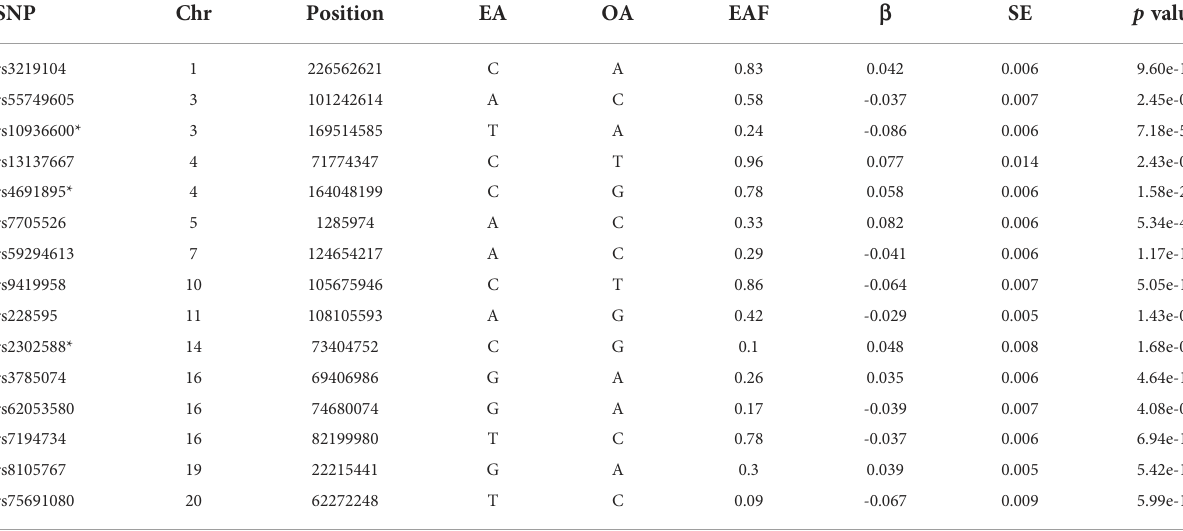
TABLE 1 Characteristics of 15 LTL-related SNPs selected as IVs for LTL-MS associations. Chr